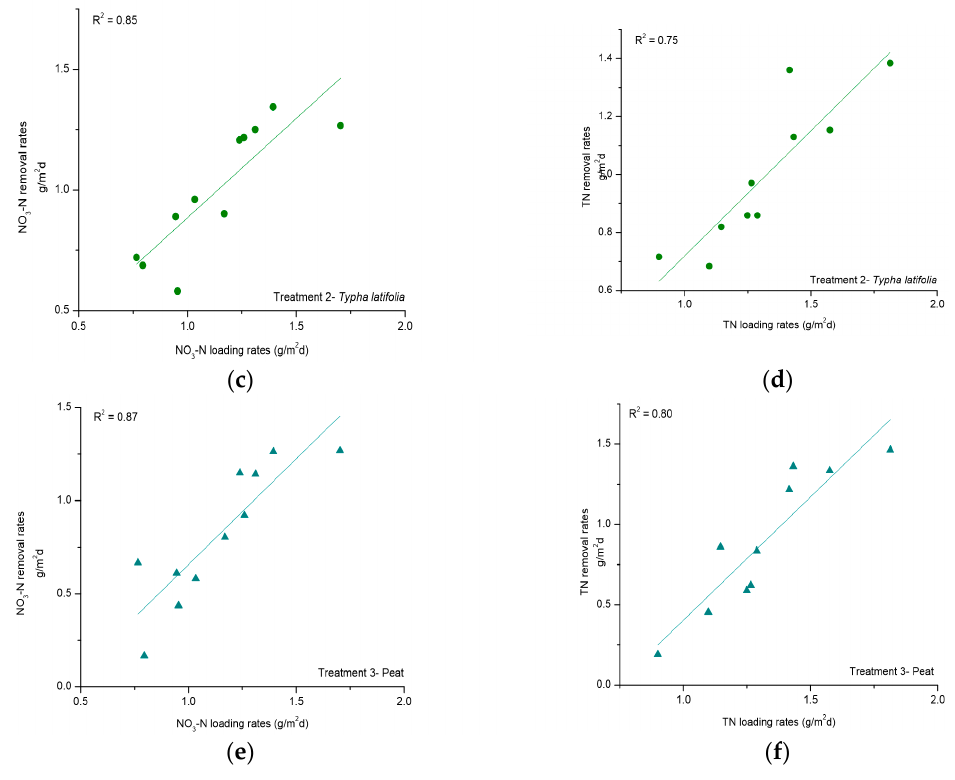
Figure 4. Correlation plots of: T1-NO3-N ( a ); T1-TN ( b ); T2-NO3-N ( c ); T2-TN ( d ); T3-NO3-N ( e ); and T3-TN ( f ) loading rates and removal rates in T1, T2 and T3 over the entire experimental period.